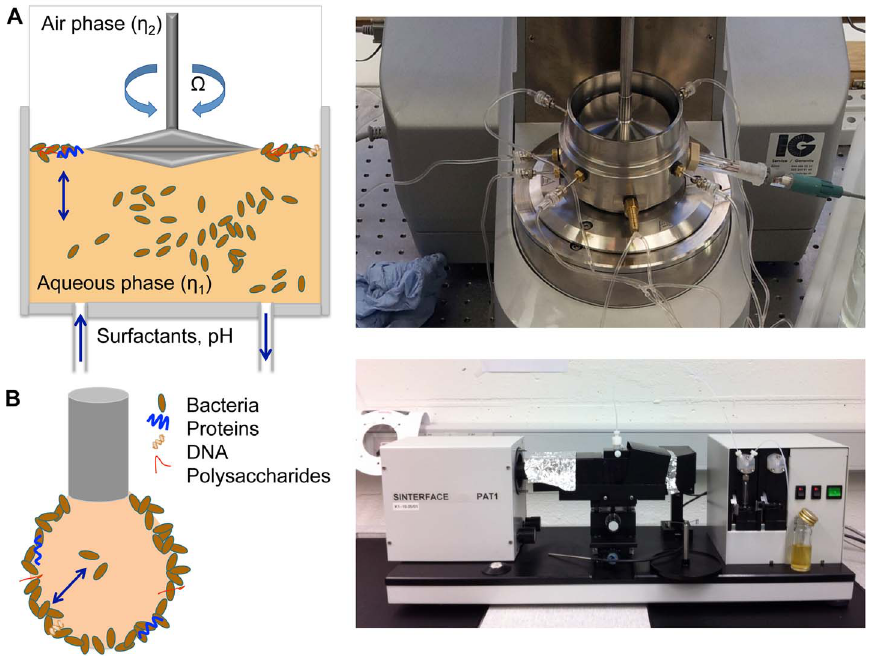
Figure 1. Overview on the experimental techniques used to measure the biofilm elasticity. A: Schematic overview over subphase controlled interfacial rheological setup used for the bacterial biofilm elasticity measurements. B: Schematic representation on the pendant drop tensiometer with an biofilm.